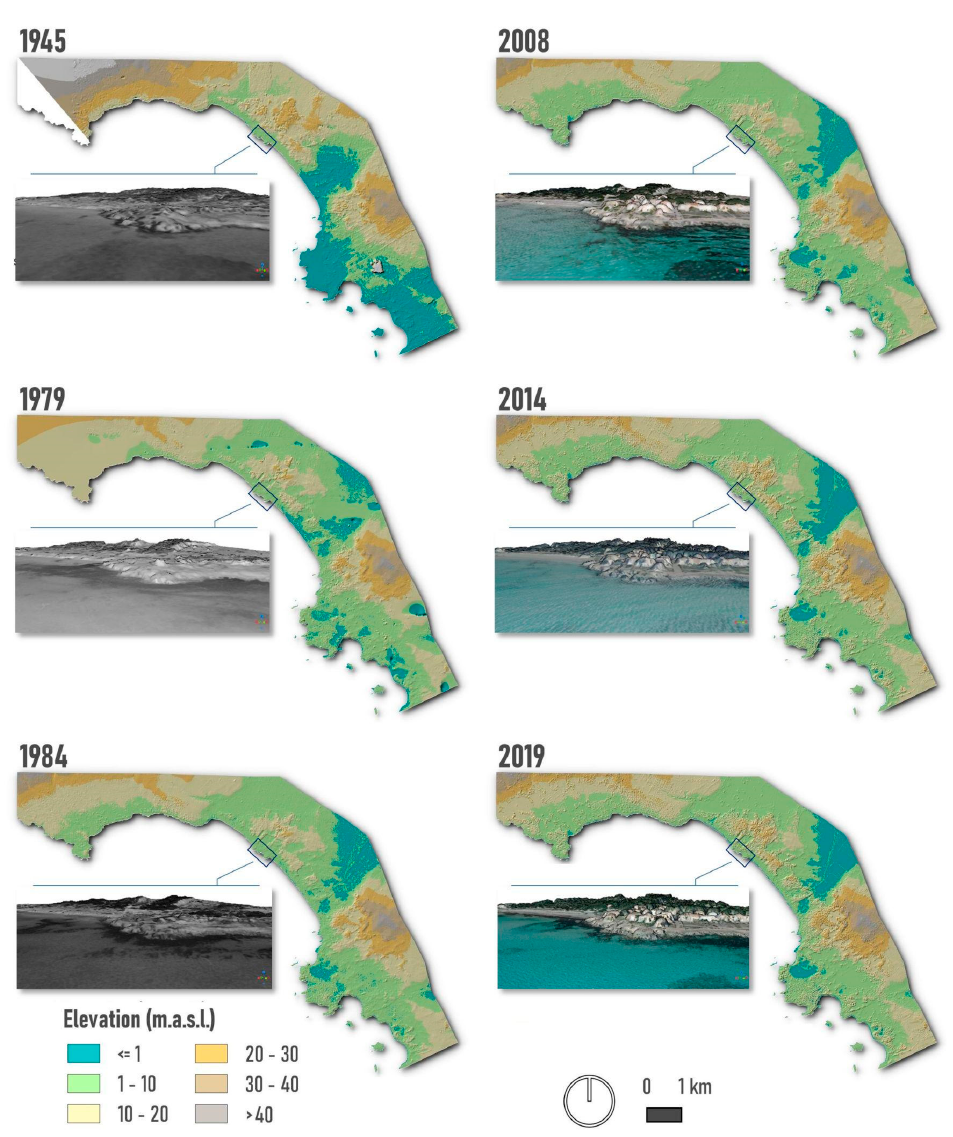
Figure 9. Elevation of historical DSM series superimposed on hillshade layers and 3D view (orthomosaics superimposed on the corresponding DSM) of a selected sector (Ses Covetes) within the study area.